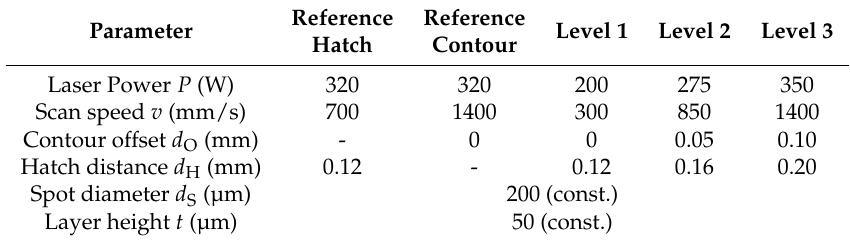
Table 1. Manufacturer’s settings as a reference and different levels for optimization of SLM parts made of 1.2709. Note that the manufacturer does not make any distinction between the interior (hatch) and upskin surfaces.